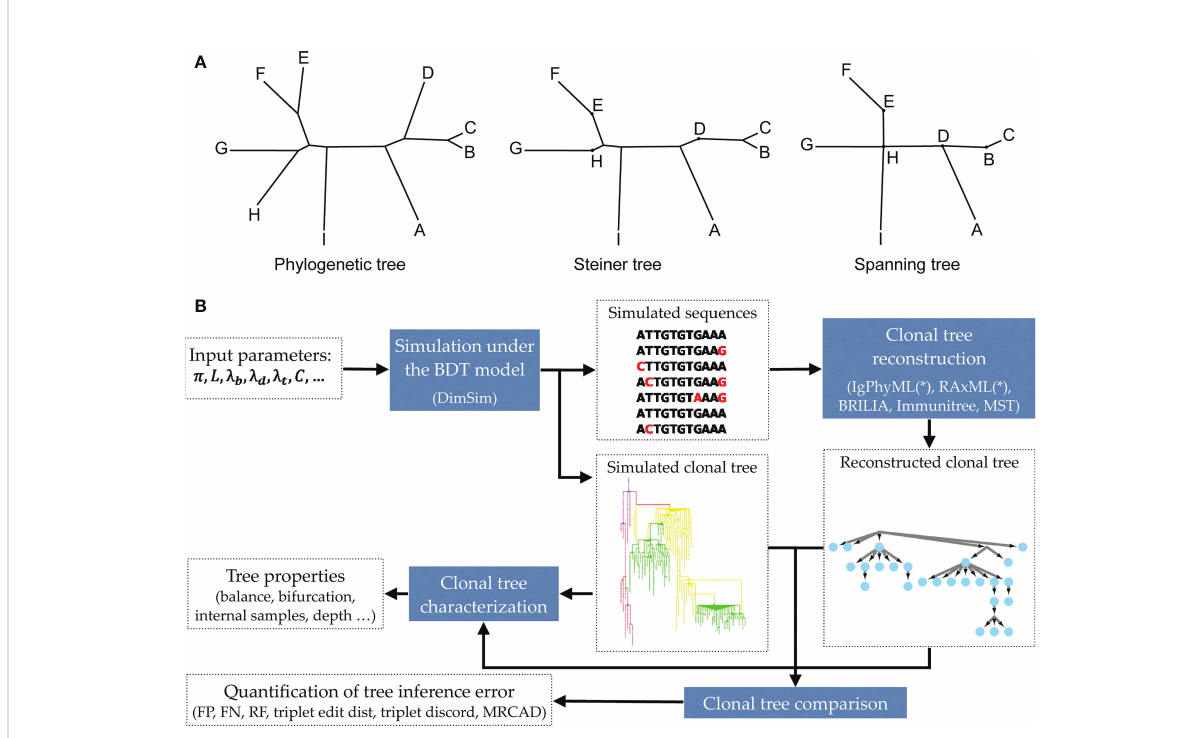
FIGURE 1 (A) Examples of a phylogenetic tree, a Steiner tree, and a spanning tree. Letters indicate sequenced data. Phylogenetic trees put all data points at leaves, and none at internal nodes, spanning trees put data at every node (whether internal or leaf), and Steiner trees are in between (some but not all internal nodes correspond to data). (B) The evaluation framework. The BDT model, parameterized by several values (Table 1) is fi rst sampled using the fast algorithm implemented in DIMSIM to create the simulated (i.e., “ true ” ) sequence data and clonal trees. These trees are then reconstructed from the simulated sequence data using various methods. The reconstructed clonal tree is compared to the simulated tree using several metrics adopted here to account for internal node sampling and multifurcation. Properties of true and inferred trees are measured using metrics such as balance and